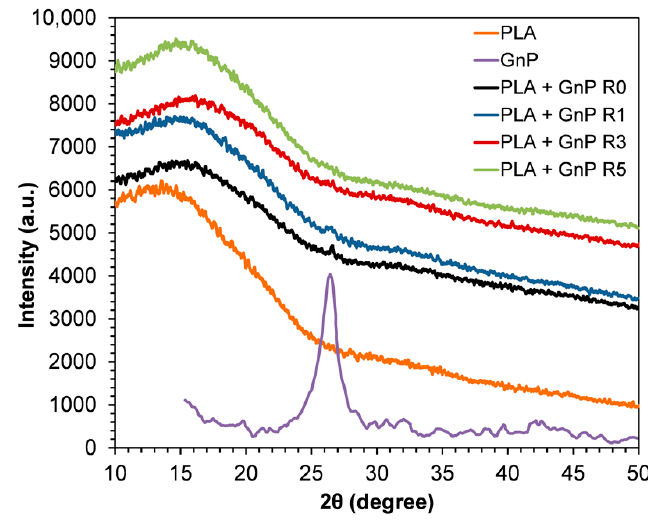
Figure 4. XRD patterns of neat GnP, PLA R0 and PLA + GnP nanocomposites at different reprocessing cycles.